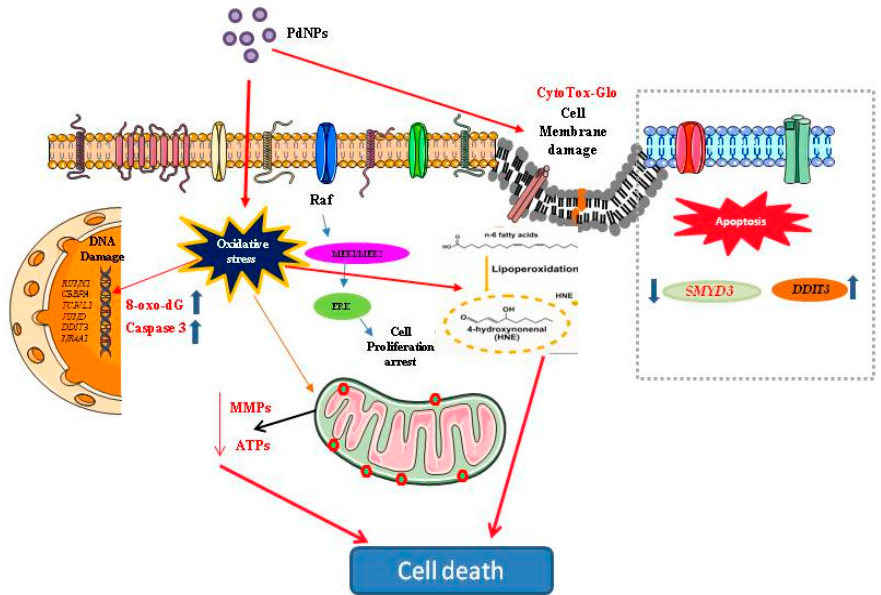
Figure 13. Hypothetical model demonstrating that the cellular mechanisms of PdNPs-induced oxidative stress, toxicity and gene expression.